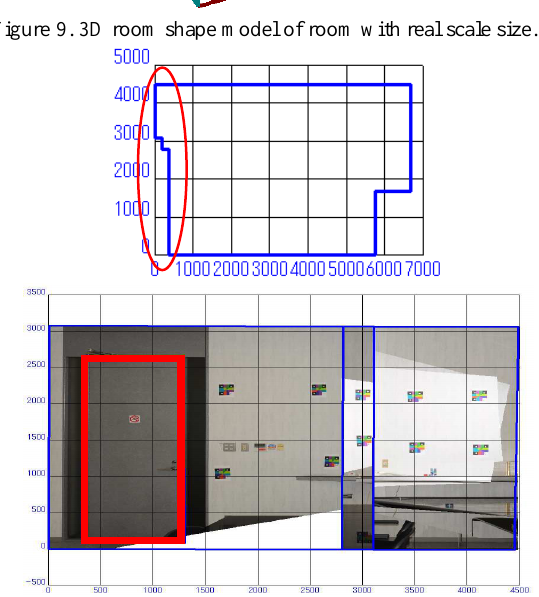
Figure 10. Development figure. Top: floor plan of 3D shape model. Bottom: development figure for one direction. Added Door (red square).